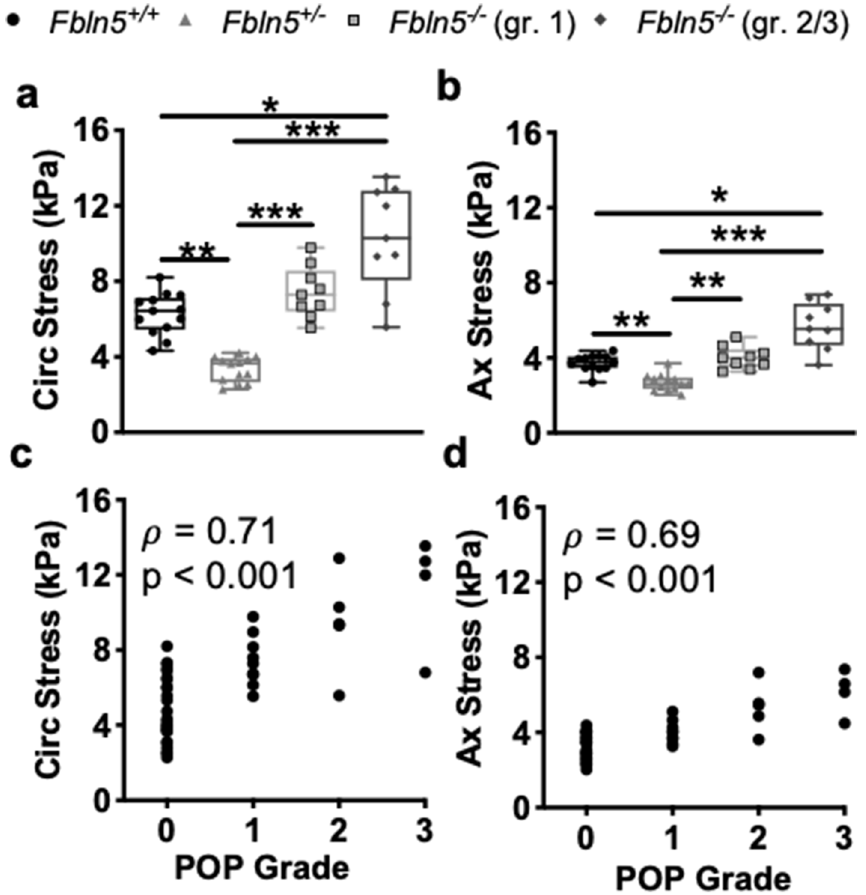
Figure 5. Vaginal wall physiologic stress at the mean in vivo pressures. Circumferential stress reported as box and whisker plots ( a ). The box and whisker plots graphically display the median, lower and upper quartiles, and lower and upper extremes of data in the Fbln5 +/+ (circle; n = 13), Fbln5 +/− (triangle; n = 13), Fbln5 -/- with grade 1 POP (square; n = 9), and Fbln5 -/- with grade 2/3 POP (diamond; n = 9) vaginas. Fibulin-5 insufficiency and POP significantly affected (p < 0.001) circumferential stress. Circumferential stress increased in the Fbln5 −/− vagina with grade 2/3 POP compared to Fbln5 + / + (p = 0.04) and Fbln5 +/− (p < 0.001) vaginas . Circumferential stress decreased in the Fbln5 +/− vagina compared to Fbln5 + / + (p = 0.003) and Fbln5 −/− with grade 1 POP (p < 0.001). Axial stress reported as box and whisker plots for the Fbln5 +/+ , Fbln5 +/− , and Fbln5 -/- with grade 1 and 2/3 POP ( b ). Fibulin-5 insufficiency and POP significantly affected (p < 0.001) axial stress. Axial stress increased in the Fbln5 −/− vagina with grade 2/3 POP compared to Fbln5 + / + (p = 0.03) and Fbln5 +/− (p < 0.001) vaginas . Axial stress decreased in the Fbln5 +/− vagina compared to Fbln5 + / + (p = 0.008) and Fbln5 −/− with grade 1 POP (p = 0.003). In addition to identifying significant differences in stress, the data was separated according to POP grade: 0 (n = 26), 1 (n = 9), 2 (n = 5), 3 (n = 4). Pearson’s or nonparametric Spearman’s test evaluated the correlation between stress with POP grade. Circumferential ( c ) and axial ( d ) stresses positively correlated with POP grade. Statistical significance is denoted by *p < 0.05, **p < 0.01 and ***p <